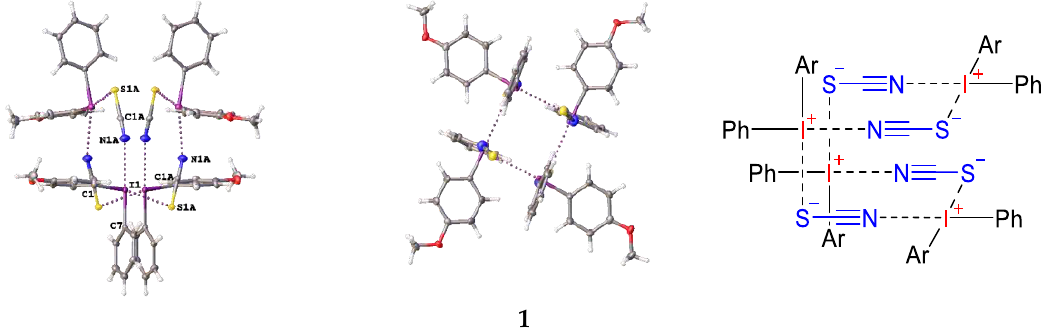
Figure 1. The ( ··· I ··· SCN ··· ) 4 16-membered halogen bonding (XB)-involving moiety in 1 Figure 1. The (···I···SCN···) 4 16-membered halogen bonding (XB)-involving moiety in 1 .